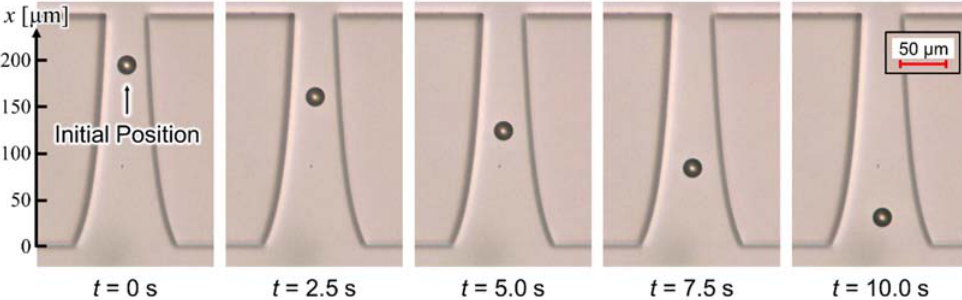
Figure 7. Behavior of the nDEP-exhibited particle. The applied voltage and frequency were 40 V p-p and 1 MHz, respectively. The particle individually moved on the centerline between insulators without levitation.